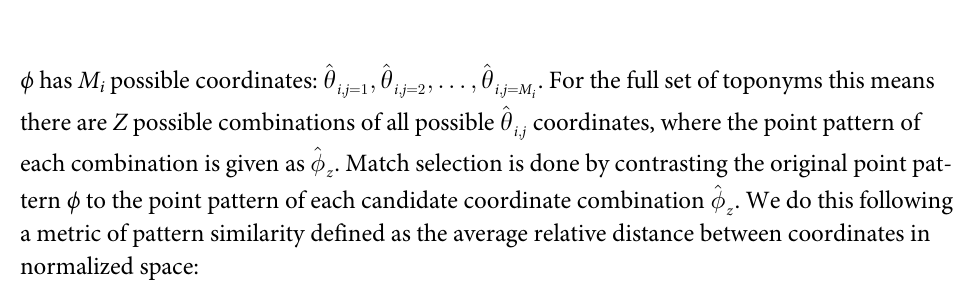
Fig 4. Normalized point pattern coordinates. Pattern matching of image placename toponyms Mbe, Poli, and Tchollire and coordinate combinations in normalized space.